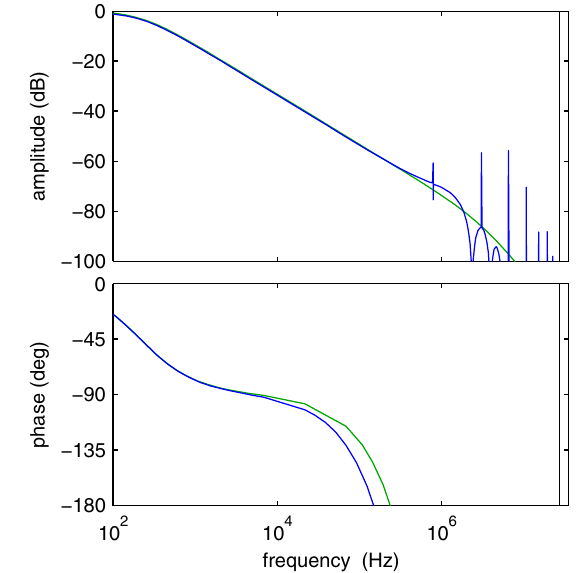
FIG. 13. (Color) Bode plot of the discrete single cavity open loop transfer function (blue) for 54 MHz sampling rate, unity (cid:3) 2 (cid:1) s . Notch filters are gain G (cid:3) 1 , and loop delay (cid:4) loop (cid:2) -mode, the 7 (cid:2) -mode, and the 6 (cid:2) -mode to- applied to the 8 9 9 9 gether with an 8 MHz FIR low pass filter. For comparison, the bode plot of the transfer function containing a cavity with (cid:2) -mode only is also shown